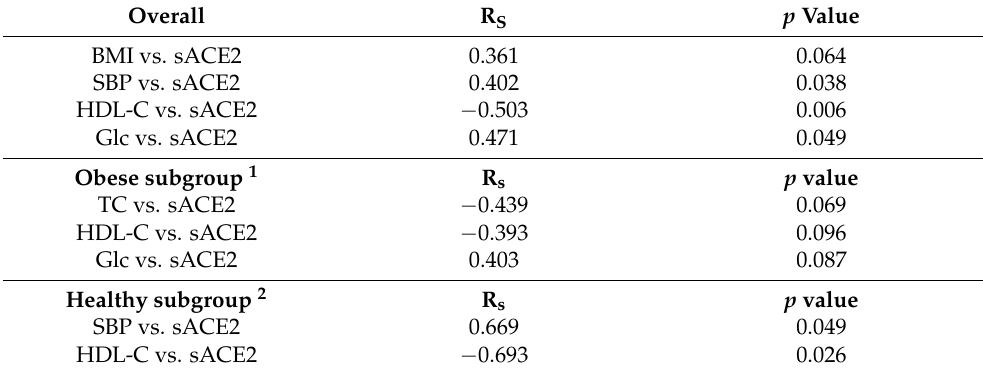
Table 1. Correlations between sACE2 levels and baseline health parameters of the